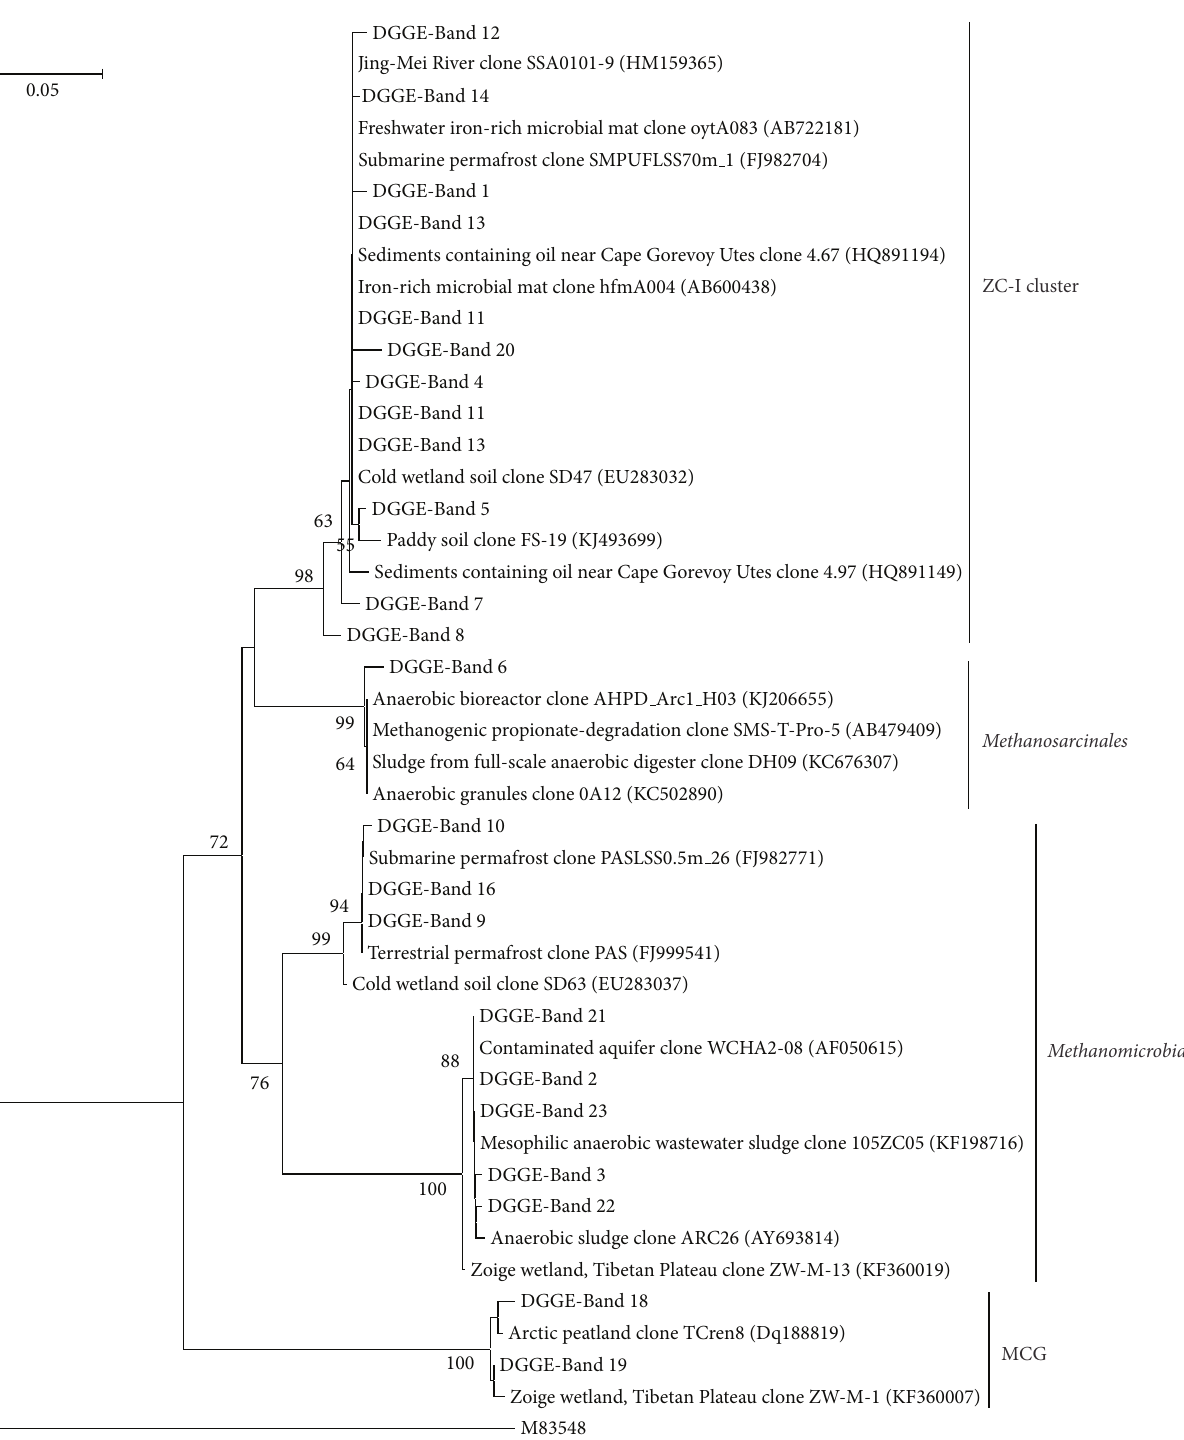
Figure 4: Phylogenetic relationships of archaeal 16S rRNA gene sequences obtained from DGGE bands in the soil profile. The scale bar represents 5% estimated